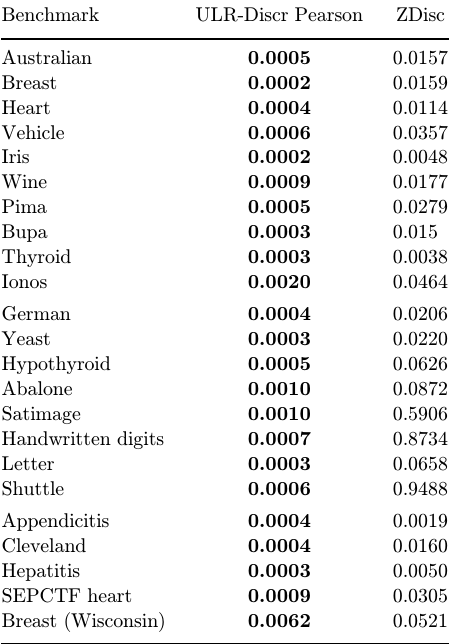
Table 9. Runtime for ULR-Discr using respectively the Pearson coe±cient and ZDisc.